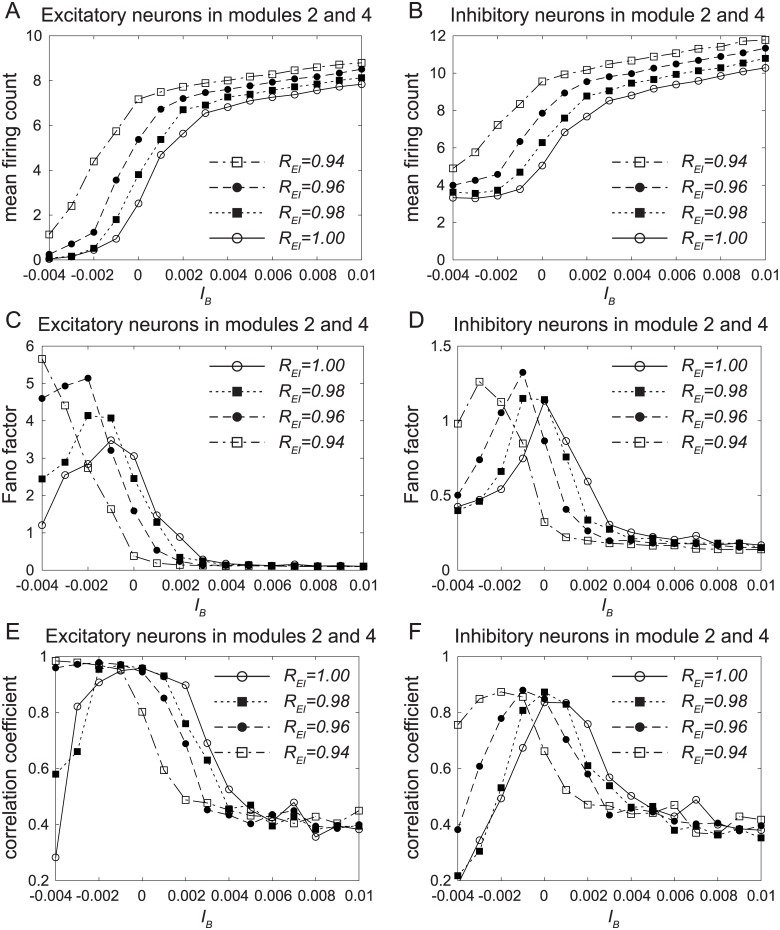
Responses of the network to the bottom-up input.The dependences of (A, B) the mean firing count, (C, D) the Fano factor, and (E, F) the correlation coefficient on the bottom-up input IB. The inputs shown in Fig 3A and 3B are applied to the network. The time-averaged statistics for 3000 ≤ t ≤ 4000 are calculated to discard transient dynamics for 2000 ≤ t ≤ 3000, and they are shown only for modules 2 and 4 because they store “1” for the pattern 1. The dependences of the firing count on IB shown in (A) and (B) represent the response functions to the bottom-up input.